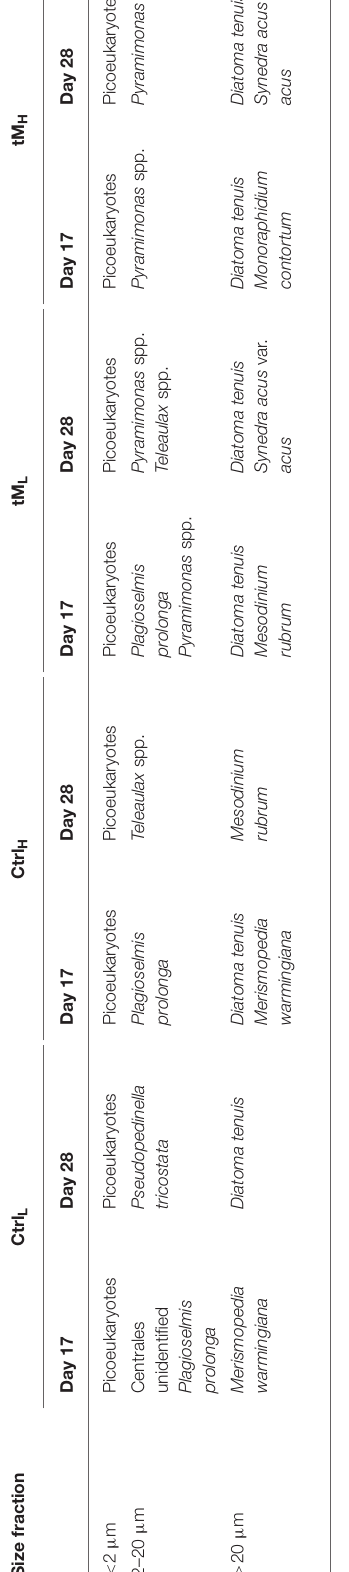
Table S1 ). The Chl a content of the phytoplankton cells, measured as the Chl a :C ratio, was on average about 50% higher in the tM supplemented mesocosms than in the controls, largely due to increase phosphorus concentrations ( Figure 7C and Supplementary Table S1